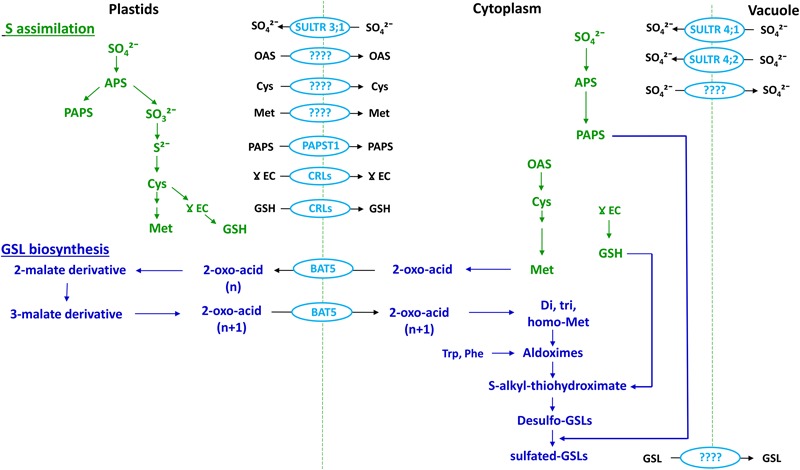
Association between the S assimilation pathway and GSL biosynthesis (emphasizing Met-derived GSLs) within a cell. Adapted from Gigolashvili and Kopriva (2014). OAS, O-acetylserine. Cellular compartments are indicated at the top of the figure. Text in green indicates S assimilation; text in dark blue indicates GSL biosynthesis and text and shapes in light blue indicate transporters.